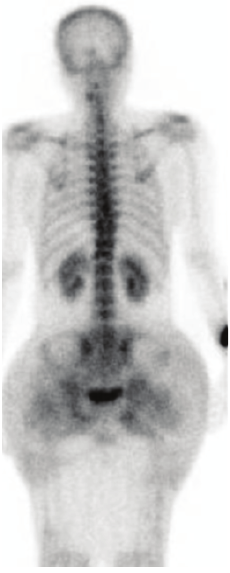
Figure 1: Tc labeled bone scan revealing diffuse heterogeneity and increased uptake at the bilateral buttocks.